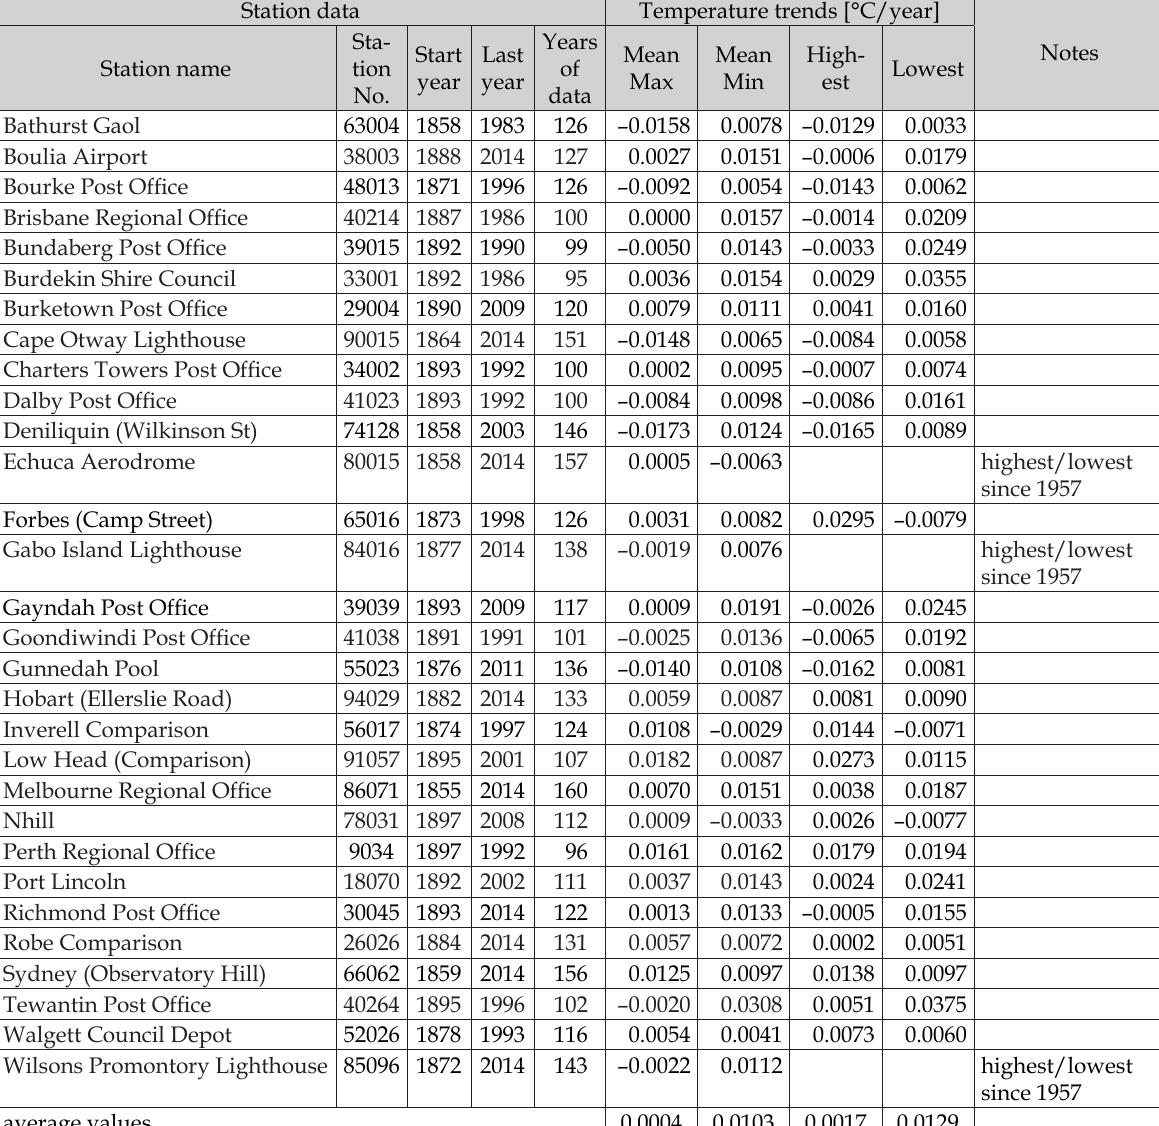
Table 1. Warming trend for the 30 longest temperature records of Australia having data collected in a single lo - cation, with measurements started before 1900 and ended after 1985. Data from Australian Government Bureau of Meteorology (BOM 2014a) accessed October 10,